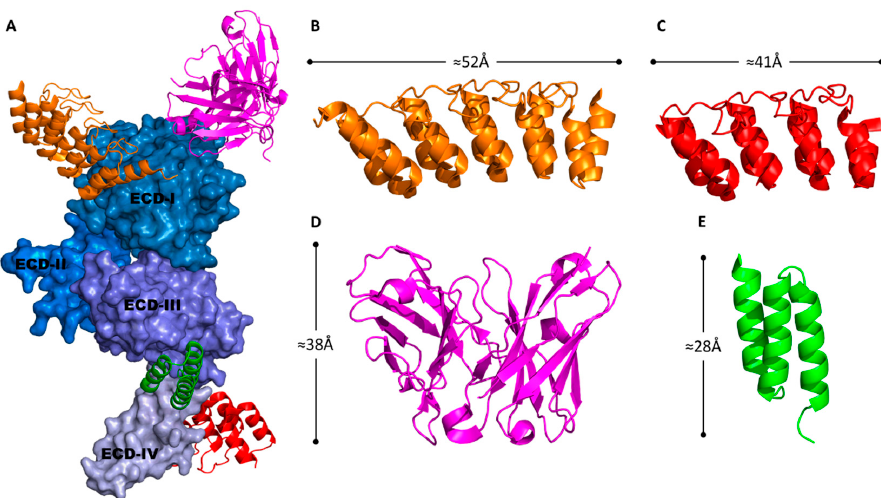
Figure 7. Overview of antibody-like proteins specific to Human Epidermal growth factor Receptor 2 (HER2) which have been genetically integrated into Adenovirus. HER2 is composed of 4 domains, Extra Cellular Domain (ECD) I-IV which can be bound by different proteins ( A ). The Designed Ankyrin Repeat Proteins (DARPIN’s) 9.29 ( B ) and G3 ( C ) are seen in orange and red complexing ECD-I and ECD-IV, respectively. ScFv chA21 ( D ) is seen in purple complexing ECD-1 (this particular ScFv has not previously been integrated to Adenovirus), and affibody ZHER2 ( E ) is seen in green binding at the ECD-III/IV interface. All molecules are shown to scale, structures from PDB: 4HRL, 4HRN, 3H3B, and 3MZW.